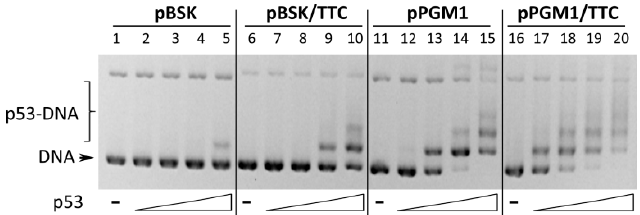
Figure 3. p53 binding to (GAA) 18 ·(TTC) 18 sequence in scDNA. Wtp53 binding to supercoiled plasmids pBSK, pBSK/TTC, pPGM1 and pPGM1/TTC was studied by EMSA in agarose gel. Wtp53 protein was incubated with scDNA (pBSK and pBSK/TTC 100 ng, lanes 1–10), scDNA containing p53CON (pPGM1 and pPGM1/TTC 100 ng, lanes 11–20) in p53/DNA molar ratios 0.5, 1, 1.5 and 2 at 4 °C. EMSA was performed at 4 °C.